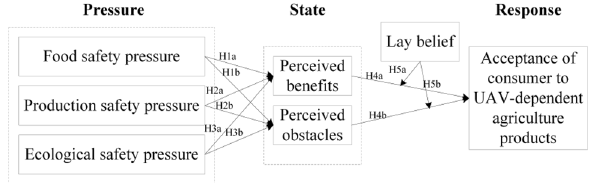
Figure 2. PSR research